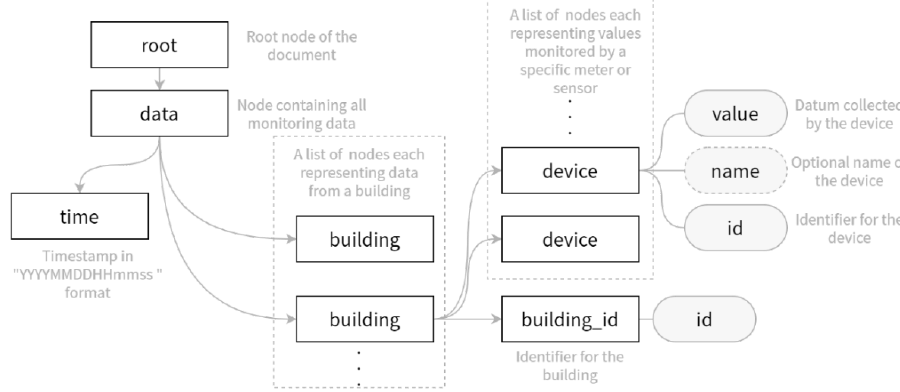
Figure 4. Graphical representation of the Extensible Markup Language (XML) protocol.